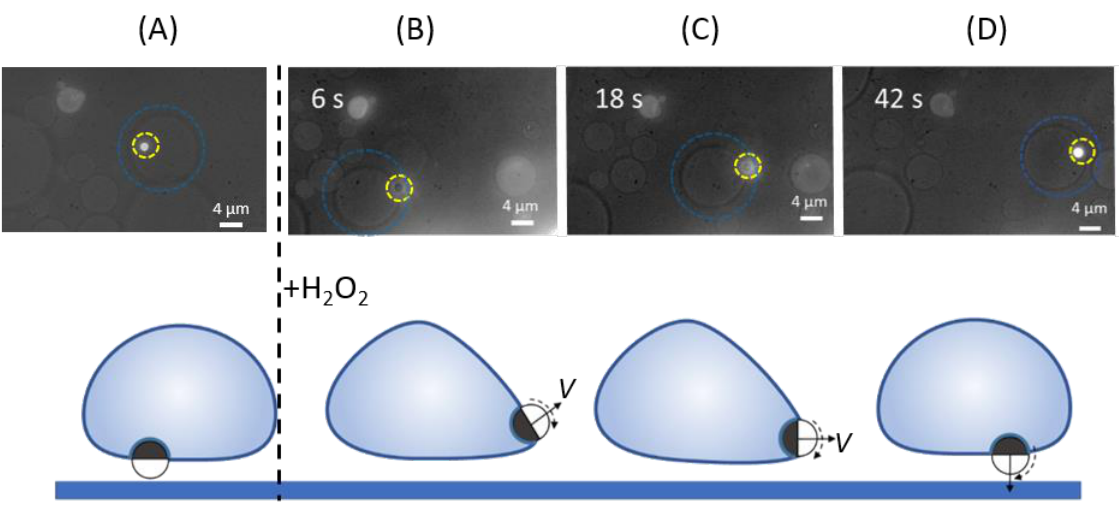
Figure 8. ( Top panel ) Fluorescence microscopy images of a MF – Pt Janus colloid partially engulfed by a GUV before ( A ) and after ( B – D ) adding hydrogen peroxide in the aqueous solution. Dashed circles are guides to identify the particle (yellow) and the GUV (blue). Images are taken from below. ( Bottom panel ) Sketches of the scenarios describing the colloid – GUV configurations observed in the experiments above.